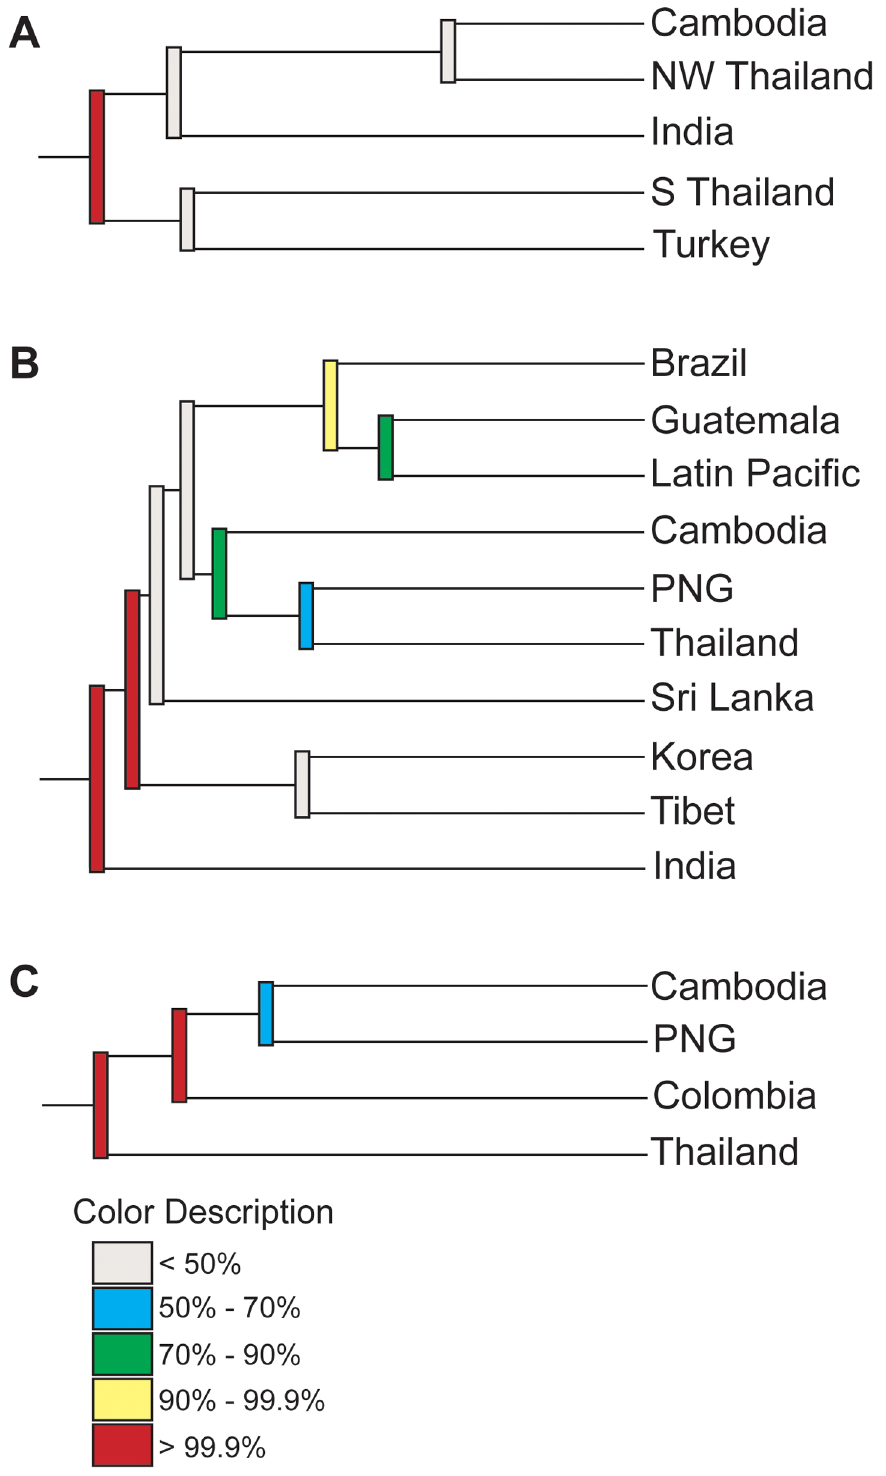
Figure 5. Jackknifed consensus trees demonstrate reproducible geographic clustering in pvcsp VK210 and VK247 isolates, but not pvmsp-1 . The reproducibility of population clustering was assessed using 1000 jackknifed phylogenies. Individual populations clustered together or apart in each of the 1000 jackknifed phylogenies, and the frequency of a split between any two populations was quantified. Populations with grey bars ( , 50% splits) were genetically similar, while populations with red bars ( . 99.9% splits) were highly genetically distinct. Phylogenies were built from the pvmsp-1 42 kDa region ( A ), the pvcsp VK210 central repeat ( B ), and pvcsp VK247 central repeat ( C ).